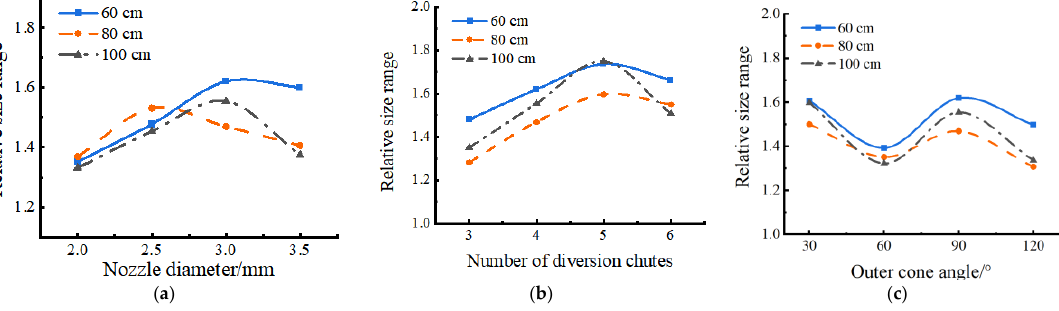
Figure 8. The influence of key structures on the relative range of droplet sizes. ( a ) Nozzle diameter; ( b ) number of diversion chutes; ( c ) outer cone angle.